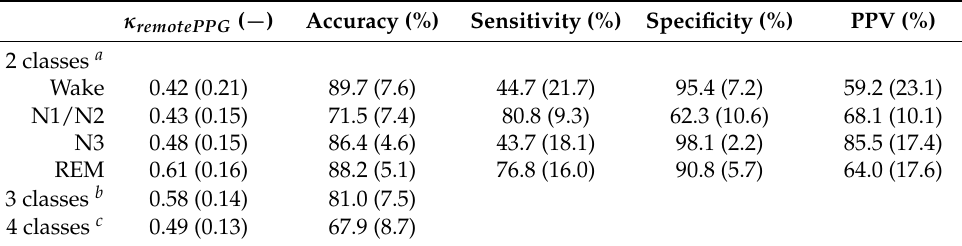
Table 1. Classification performance using remote PPG compared with the reference, i.e., manual scoring. Mean (SD) per class.